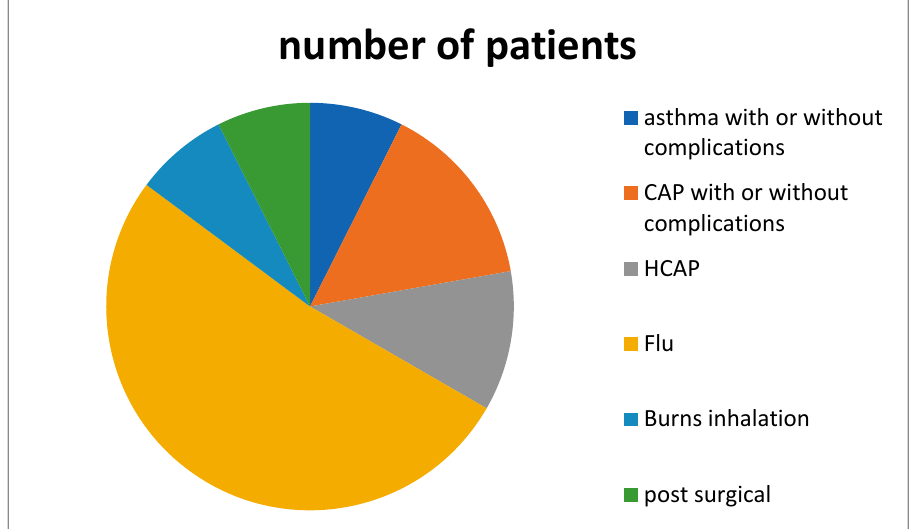
Figure 1. Background conditions in ECMO patients.